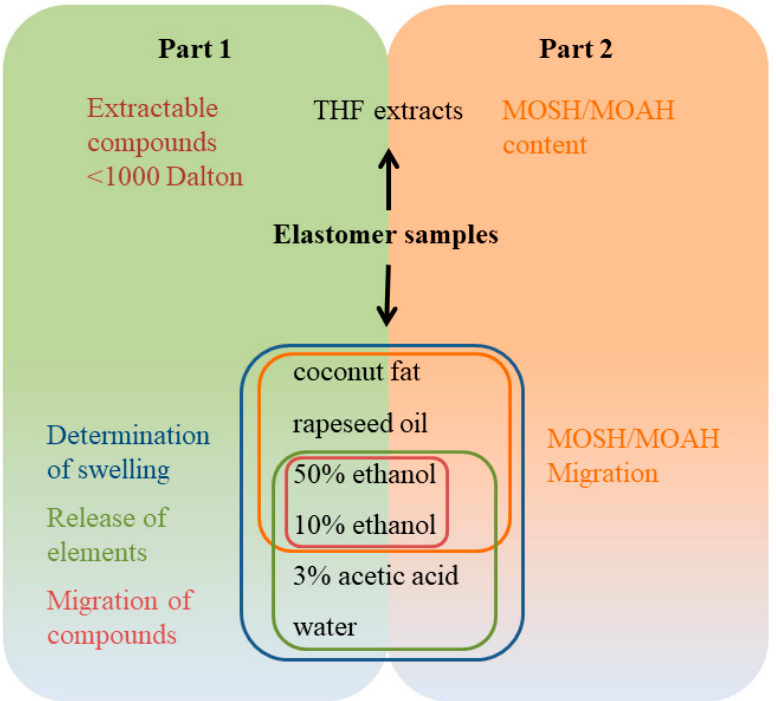
Figure 1. Overview of project—Elastomer samples were extracted (top) and used for migration experiments (bottom). Part 1 (this publication) deals with topics on the left. Part 2 (to be published) deals with the mineral oil hydrocarbons (MOH). MOSH (mineral oil saturated hydrocarbons); MOAH (and mineral oil aromatic hydrocarbons)